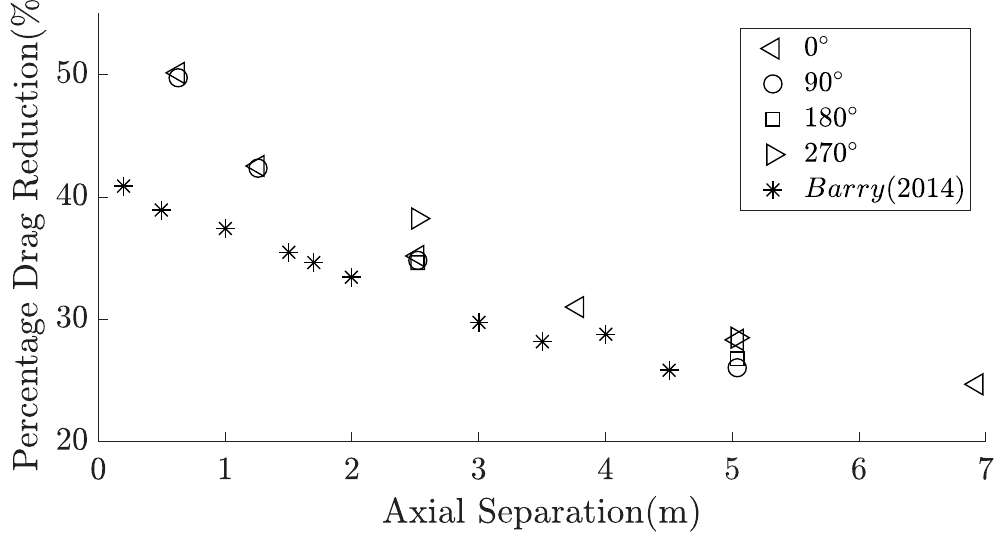
Figure 4. Percentage drag reduction (%) based upon the dynamic pressure difference for different axial separations of a trailing rider in the wake of the cycling mannequin for leg positions: 0°; 90°; 180°; 270°. The results obtained by Barry [4] are from direct force measurements of a trailing dynamic athlete in the wake of the Monash cycling mannequin with legs positioned at